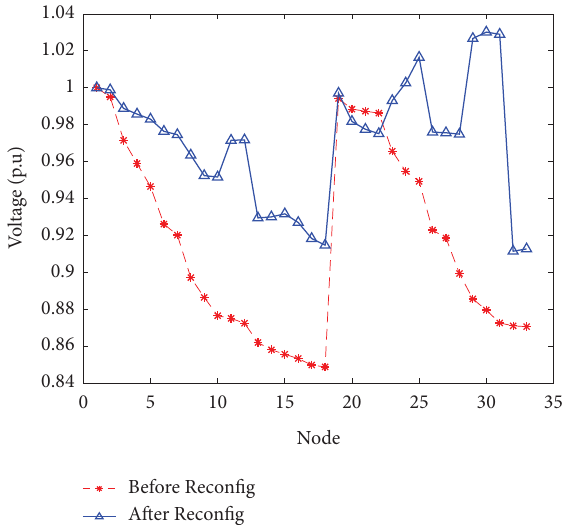
Figure 10: Voltage profle of 33-bus system for heavy load.